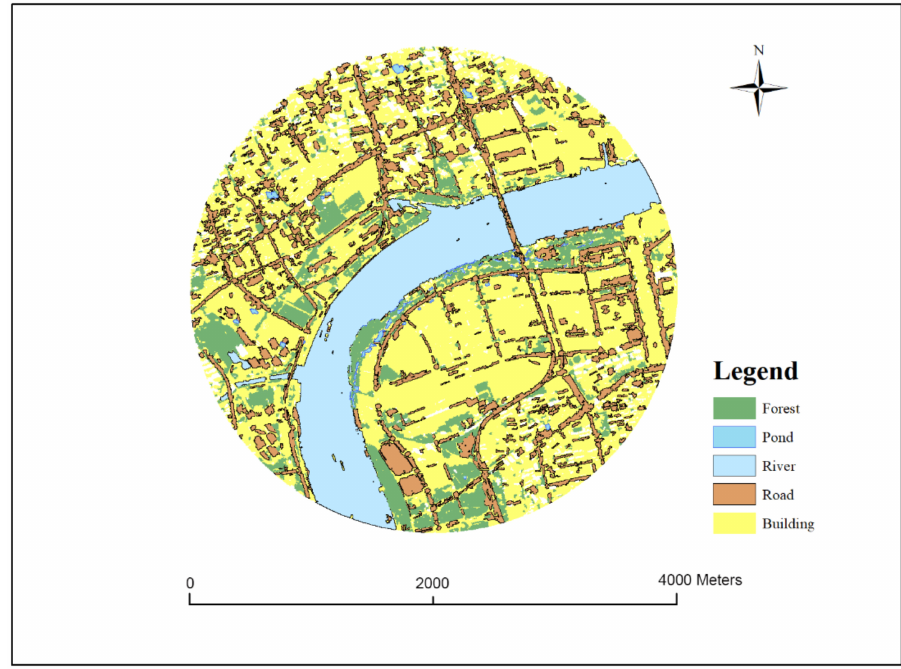
Figure 2. Example land-use map of one of the 442 km radius urban landscapes in Shanghai, China. Table 1. Landscape metrics calculated by FRAGSTATS 4.2 landscape analysis software as described by McGarigal et al. [48]. This table represents a subset (8 out of 15 metrics) that was found to not be highly correlated (|r| <